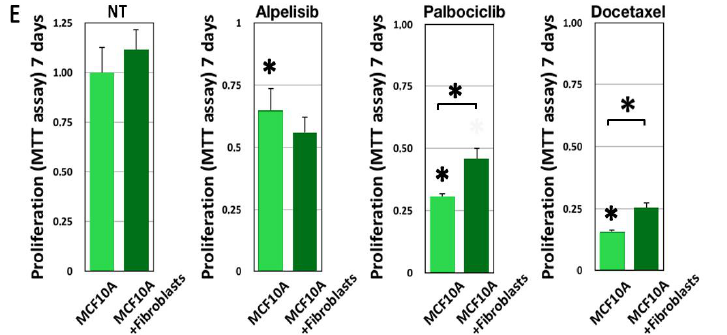
Figure 4. Drug impact is modulated by fibroblasts in our morphogenic model. MCF10A cells were grown in a collagen I/BME hydrogel with or without a GFP-labeled mammary fibroblast. MCF10A grew invasive processes that invaded the 3D matrix, visible in phase contrast (red arrows, A ) or after Hoechst dye staining (red arrows, B ). Alpelisib treatment inhibited the growth of these processes significantly ( A – C ). However, fibroblast addition enhanced the size and complexity of these invasive processes in all cases (white arrows). Fibroblasts alone were not sensitive to the doses of treatment used for MCF10A, except for Palbociclib ( D ). Adding fibroblasts had no effect on untreated MCF10A viability, enhanced the impact of Alpelisib, but significantly protected the MCF10A from Palbociclib and Docetaxel treatment ( E ). Fibroblast-conditioned medium had the same impact as co-cultured fibroblasts on Alpelisib and Docetaxel treatment ( F ). Scale bar: 100 µm. * for p < 0.05 in a Student T test comparing treated with untreated cells. * with brackets is for p < 0.05 in a Student T test comparing columns as indicated.